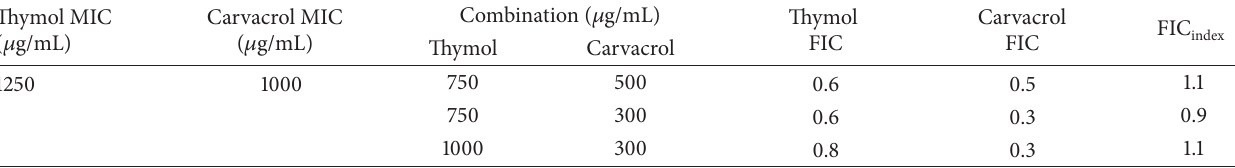
Table 4: Combined effect of thymol and carvacrol to achieve inhibition of Micrococcus luteus . Thymol MIC